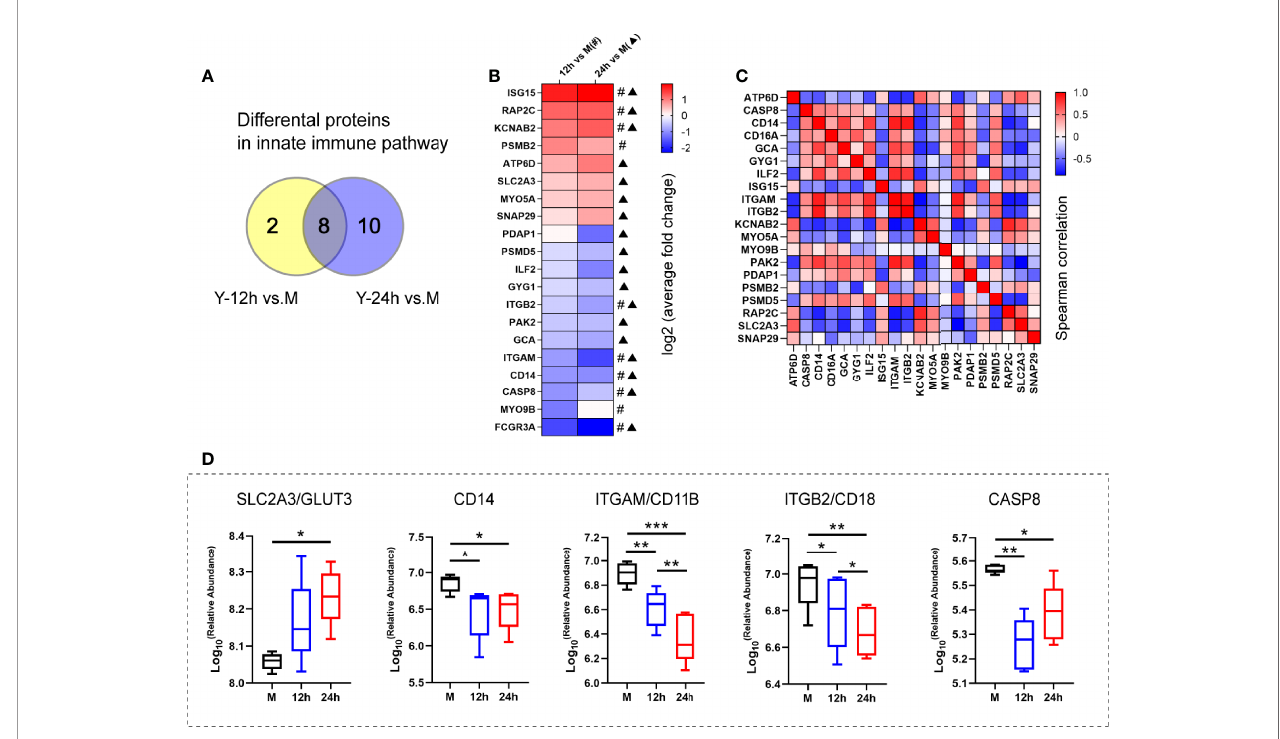
FIGURE 4 | The analysis of the innate immune pathway-related proteins. (A) Venn diagrams depict the differential proteins in innate immune pathway after 12 h and 24 h stimulation by heat-killed C. albicans versus the M group. (B) The average fold changes of 20 differential proteins for those signi fi cantly regulated in at least one comparison group (Y-12 h versus M: # or Y-24 h versus M: ▲ ) were analyzed. The fold changes of proteins were logarithmic transformed. (C) Correlation matrix of innate immune pathway-related proteins. (D) Selected the up-regulated GLUT3 and down-regulated (ITGAM/CD11B, ITGB2/CD18, CD14 and CASP8) in the innate immune pathway are shown. *** P < 0.001; ** P < 0.01; * P <